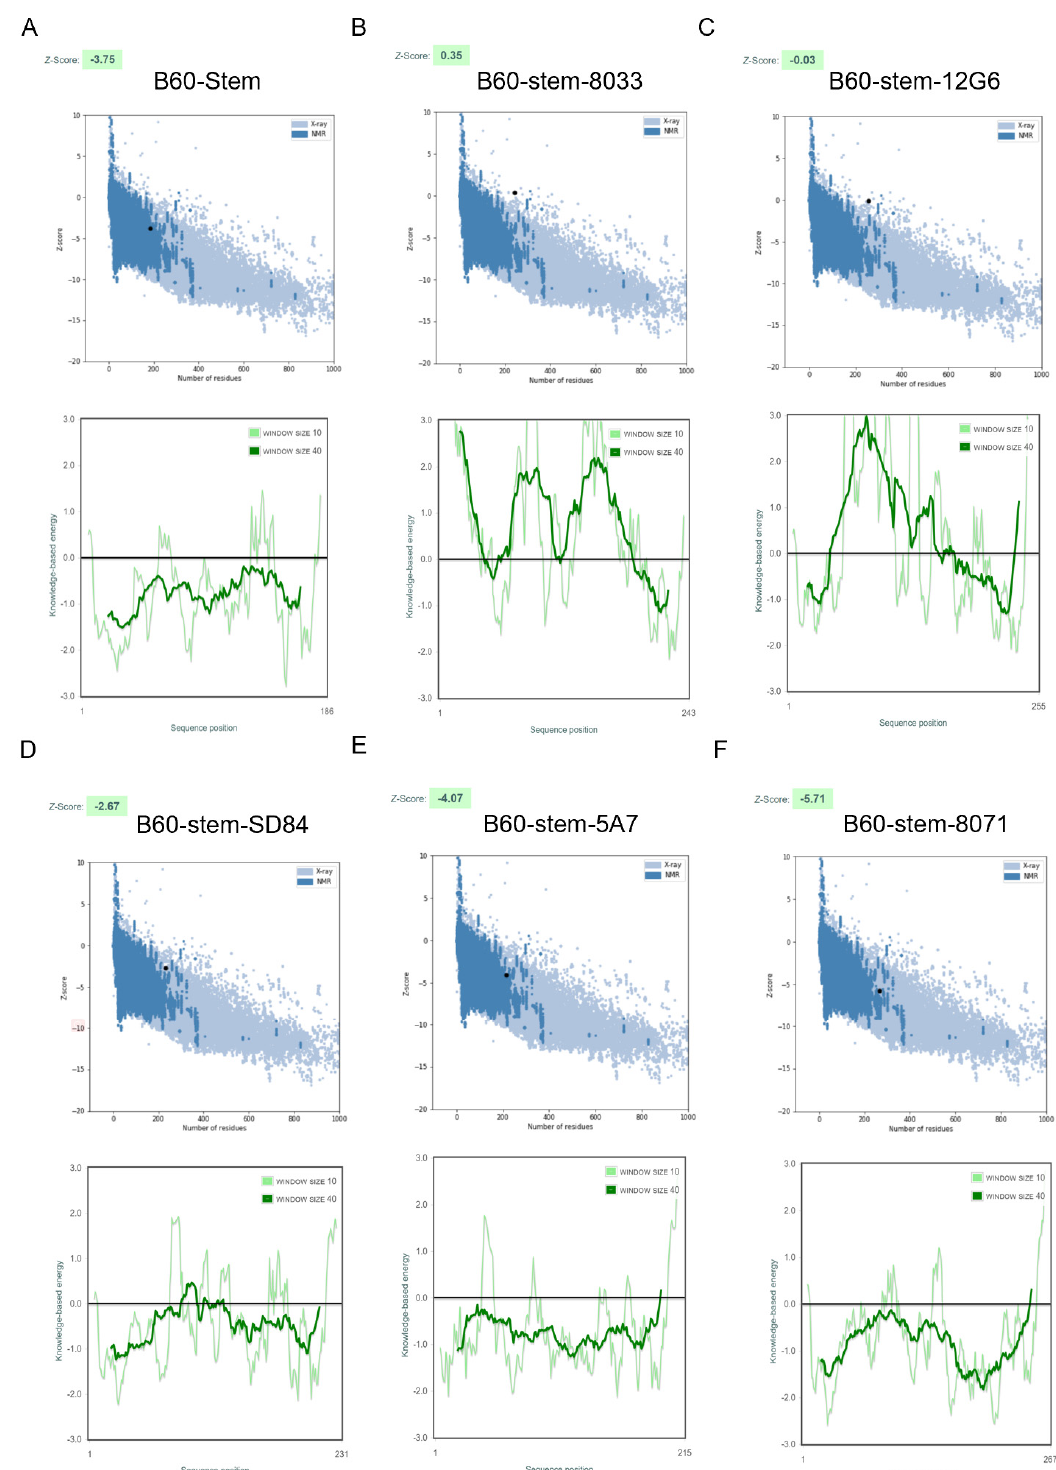
Figure 2. Three-dimensional vaccine design structure validation by ProSA-web. The Z-score of the refined models ( A ) (B60-Stem: − 3.75); ( B ) (B60-Stem-8033, 0.35); ( C ) (B60-Stem-12G6: − 0.03); ( D ) (B60-Stem-SD84: − 2.67); ( E ) (B60-Stem-5A7: − 4.07); ( F ) (B60-Stem-8071: − 5.71). ProSA-web also plots the residue scores to check the local model quality and the negative values suggest no erroneous parts of the model